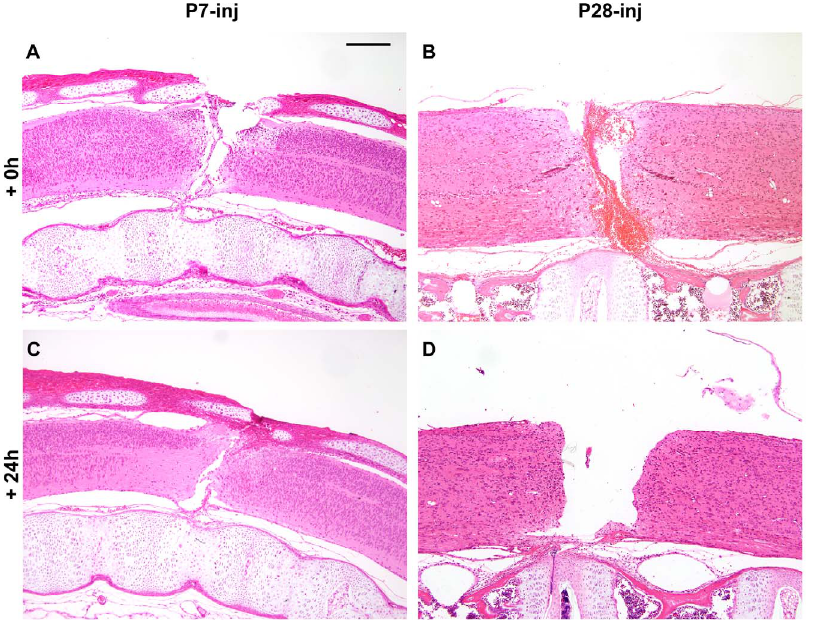
Figure 1. Monodelphisdomestica spinal cords injured at P7 or P28. Longitudinal sections (hematoxylin & eosin staining) of spinal cords injured at P7 or P28 shown immediately after complete spinal transection at T10 (A, B) or 24 hours later (C, D). Note obvious bleeding into the injury site at P28 (B), which was more pronounced than at P7 (A) One day after transection ( + 24 h) the gap between severed ends of the cord was larger in P28 injured animals (D) than in P7 injured animals (C). Rostral end is to the left, caudal to the right, dorsal is uppermost. Scale bar is 500 m m.